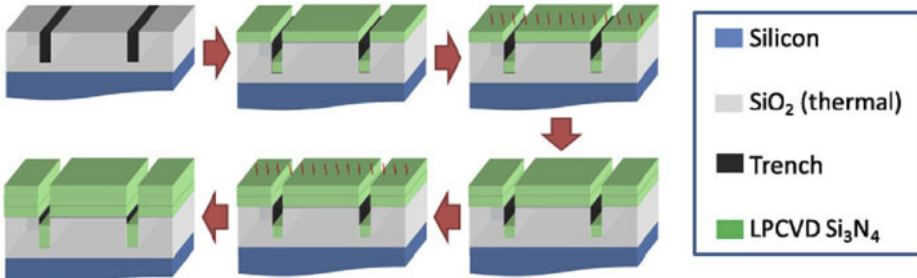
Figure 1. Schematic thermal cycling process. Trenches are formed and then, a 350nm film of Si 3 N 4 is deposited via LPCVD and annealed at 1200°C. The same process is repeated to achieve the desired thickness. Reproduced from [22] under a CC BY 4.0